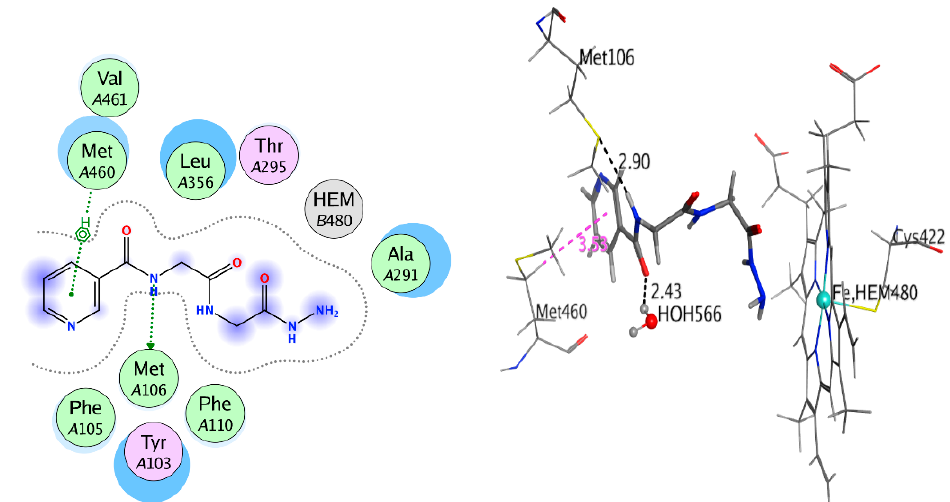
Figure 4. 2D and 3D interaction of compound 4 with 3GW9.